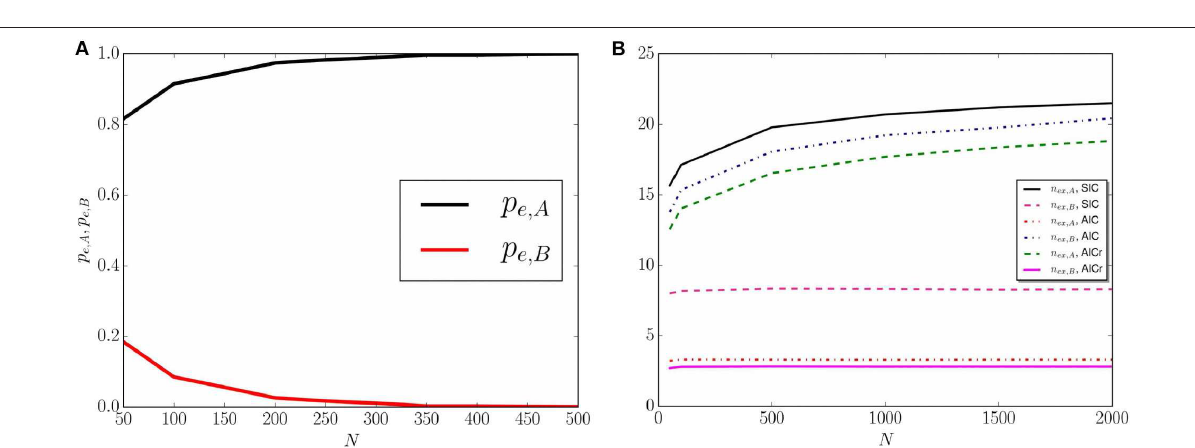
FIGURE 5 | (A) Probabilities p e , A and p e , B that the system reaches consensus at A and B respectively, vs. the system size N , obtained by averaging over 1,000 runs of a system starting with SIC. (B) Average number of examples 2,000 agents, starting with SIC, AIC, and AICr. Averages are obtained over 600 runs.